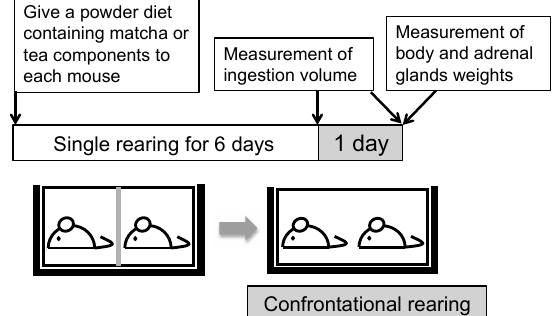
Scheme 1. Study design of the animal experiment.